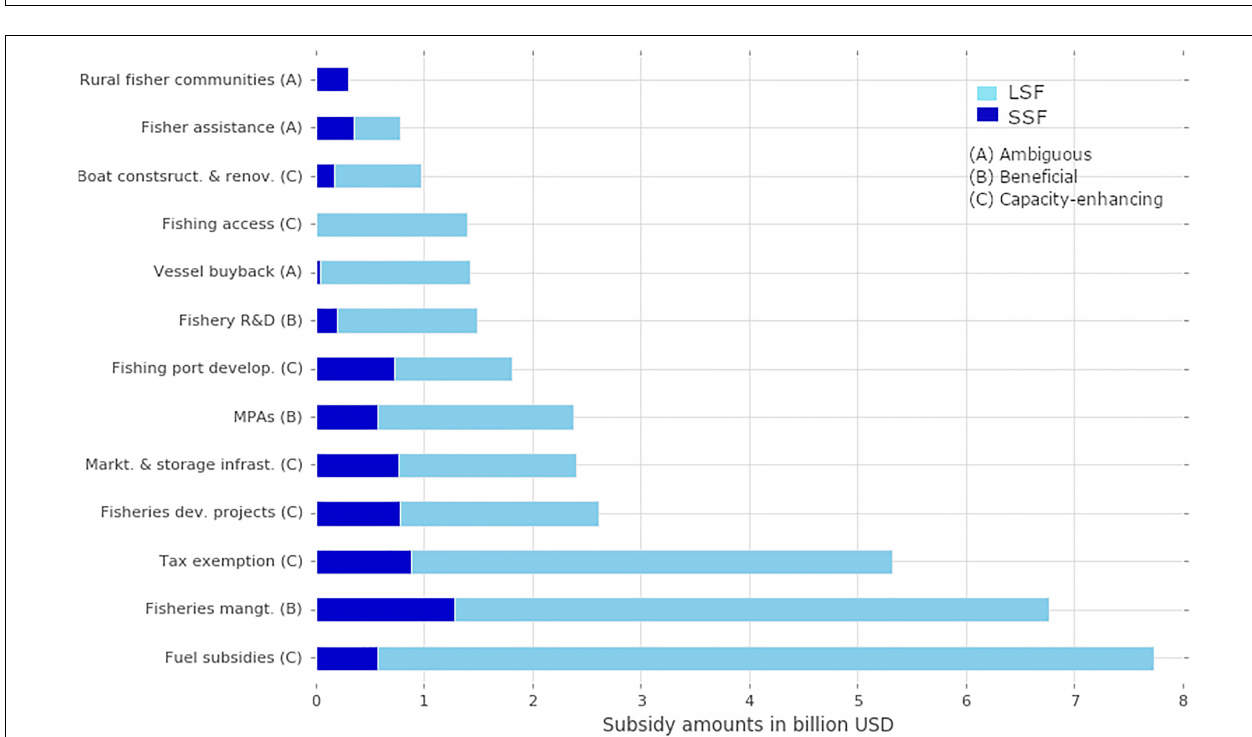
FIGURE 3 | Composition of 2018 fisheries subsidies amounts by type and grouped by SSF and LSF for 2018 (constant 2018 USD).